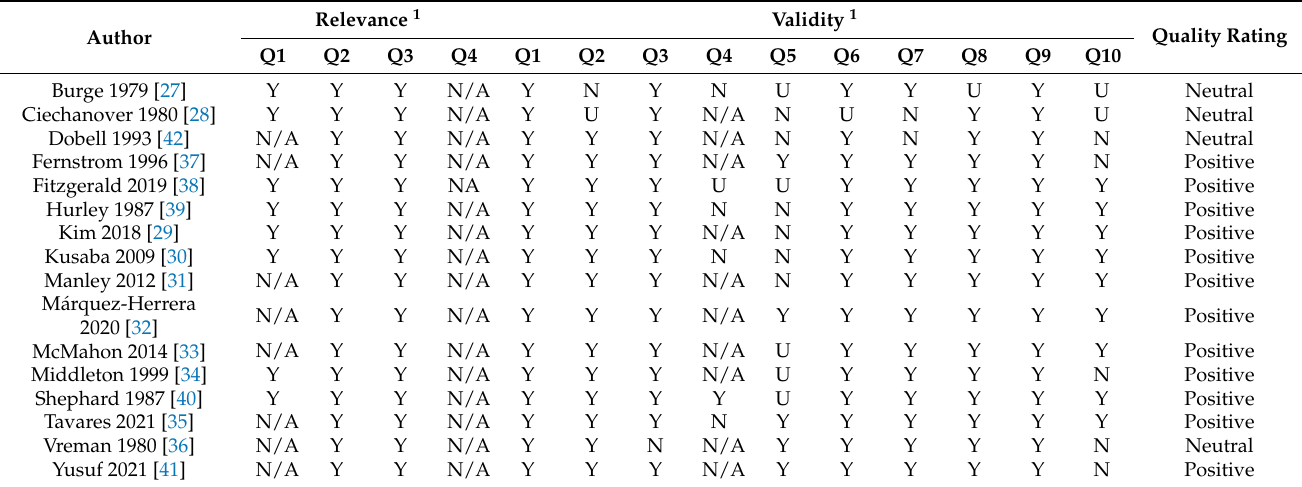
Table 1. Quality ratings of studies ( n = 16) included in this systematic review using the Academy of Nutrition and Dietetics Evidence Analysis Checklist: Primary